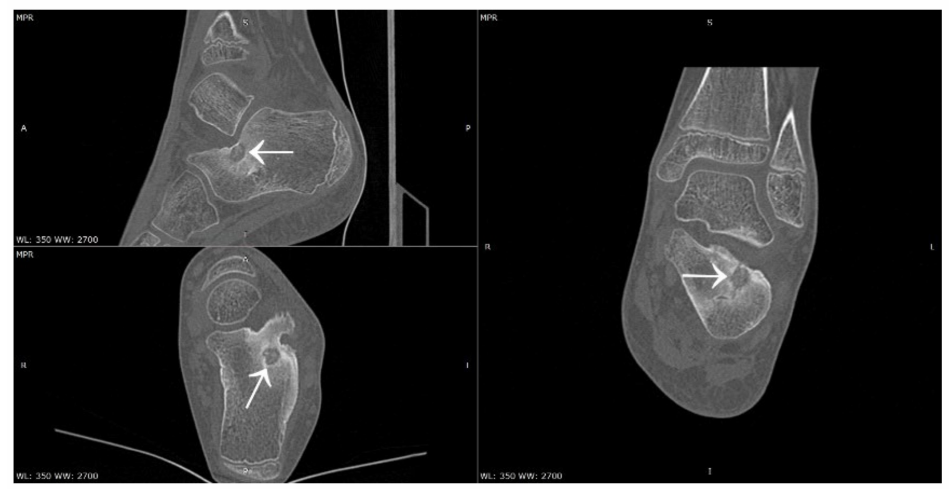
Figure 17. CT scans showing a focus of OO (arrows) in the left calcaneus.